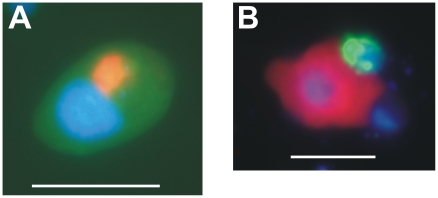
Photomicrographs of hybridized Cerc_Bal02 cells.(A) Photomicrograph of an unknown protist (olive-green) in the experimental enrichments with an ingested cell detected by probe Cerc_Bal02 (red); (B) Cercozoan cell detected with probe Cerc_Bal02 (red) ingesting a cell detected by probe Cerc_Bal01 (green). Blue objects in both panels: DAPI stained nuclei. Scale bars are 10 µm in panel A and 5 µm in panel B. Depictions are true-colour images from the same microscopic fields obtained by simultaneously exciting with several wave lengths.